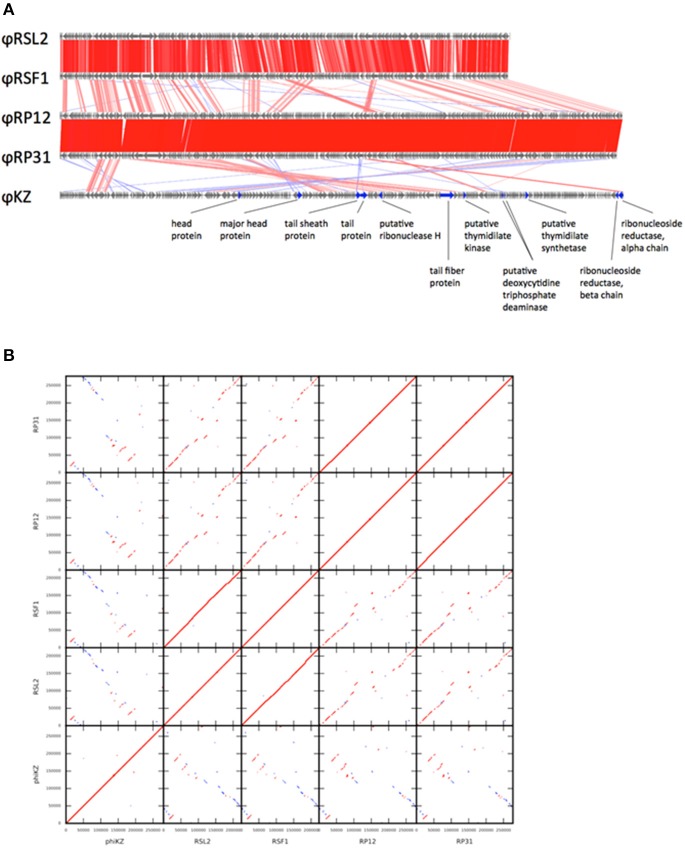
Genome comparison among five ΦKZ-related phage genomes. (A) Linear genome alignment of five ΦKZ-related phages. Red and blue lines between genomes represent sequence similarities (≥50% identity) detected by TBLASTX in the same and reverse orientations, respectively. (B) Dot-plot comparison among five ΦKZ-related phages. Red and blue lines represent sequence similarities detected by TBLASTX in the same and reverse orientations, respectively.